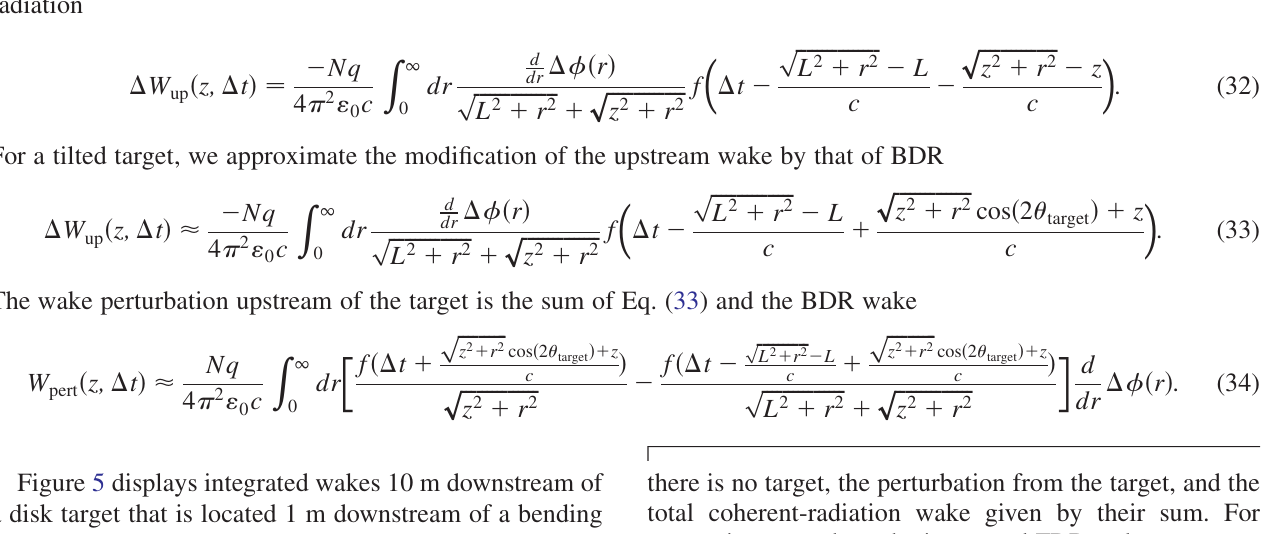
ffiffiffiffiffiffiffiffiffiffi p z 2 þ r 2